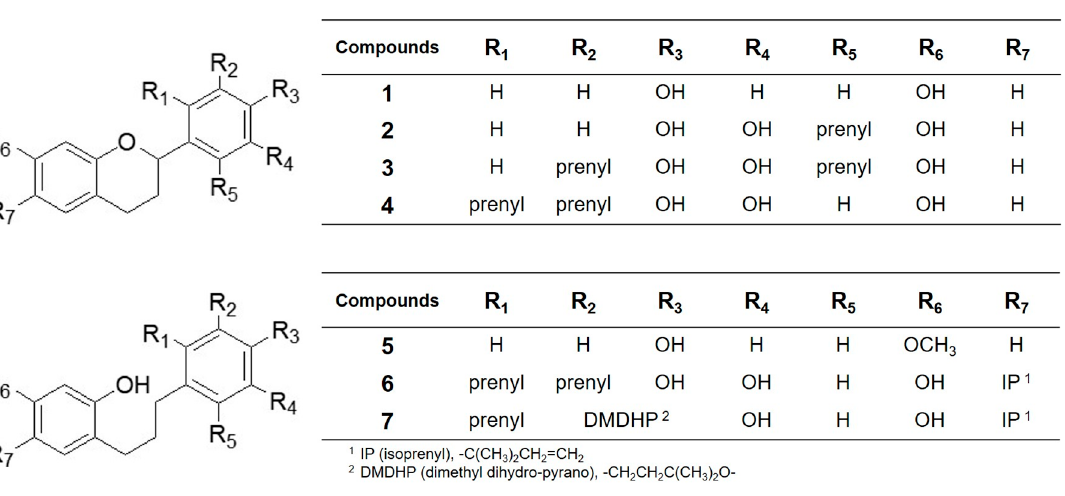
Figure 1. The chemical structures of Compounds 1 – 7 isolated from Broussonetia kazinoki .